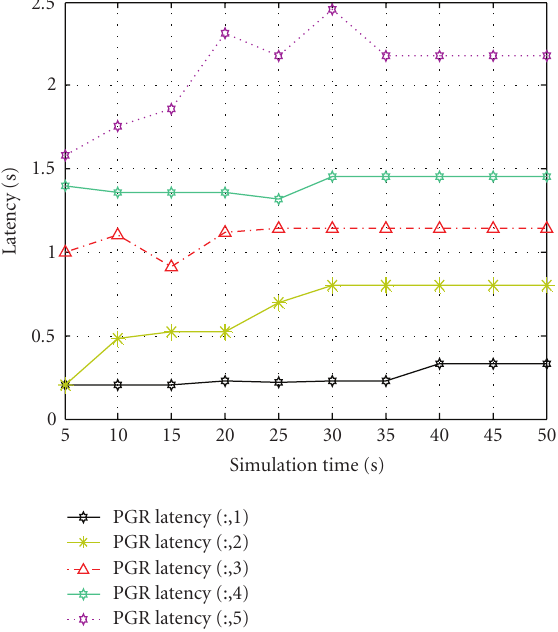
Figure 8: Simulation time and latency.